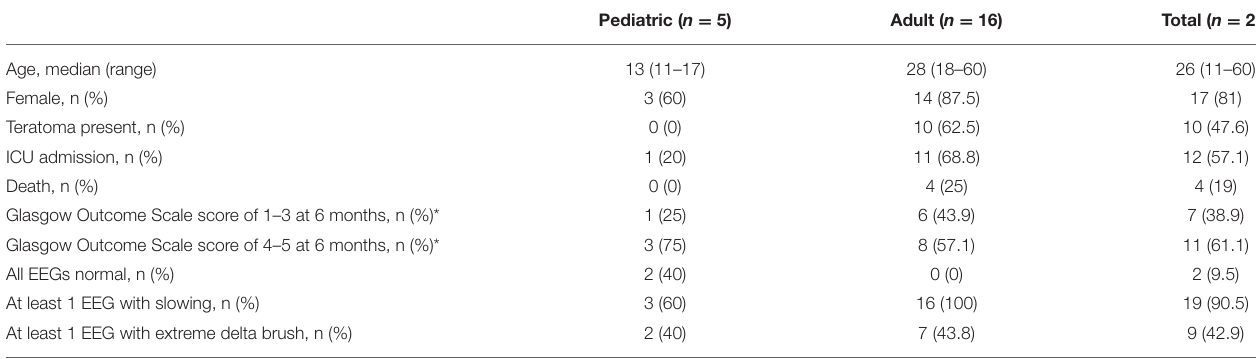
TABLE 1 | Patient demographics and EEG findings for 21 subjects with anti-NMDAR encephalitis.